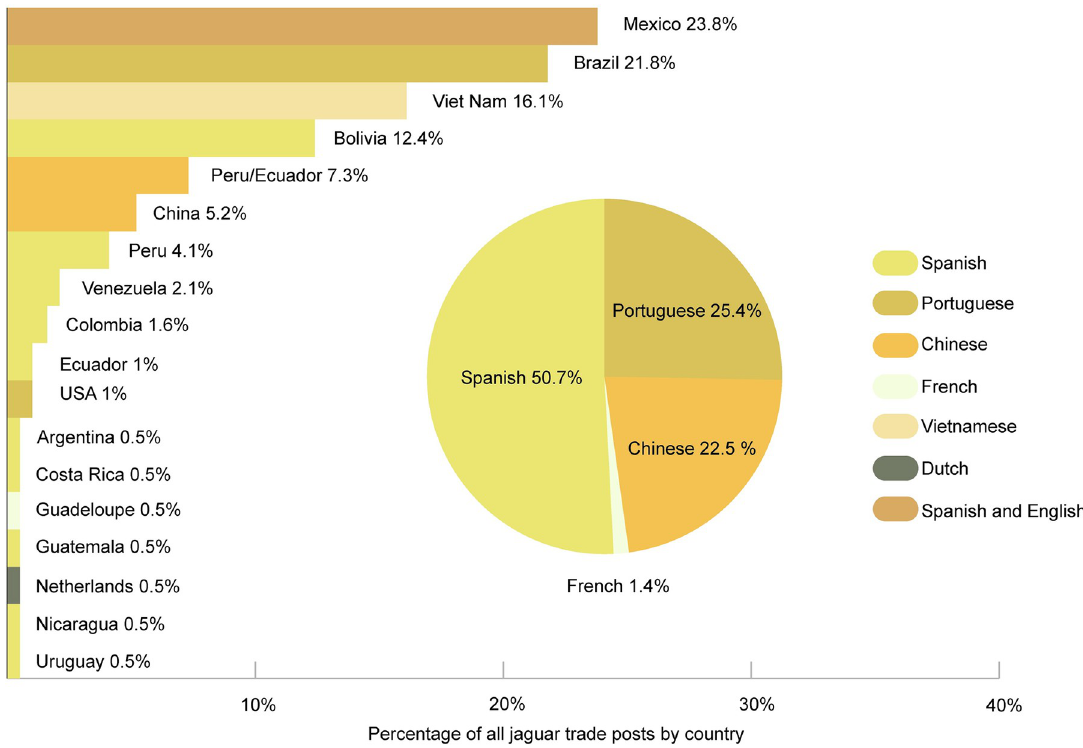
Fig 3. Percentage of posts advertising jaguar parts by country (n = 193) and the language by which they were detected. Insert is percentage of posts identified as ‘definitely jaguar’ found in each search language (n = 71).